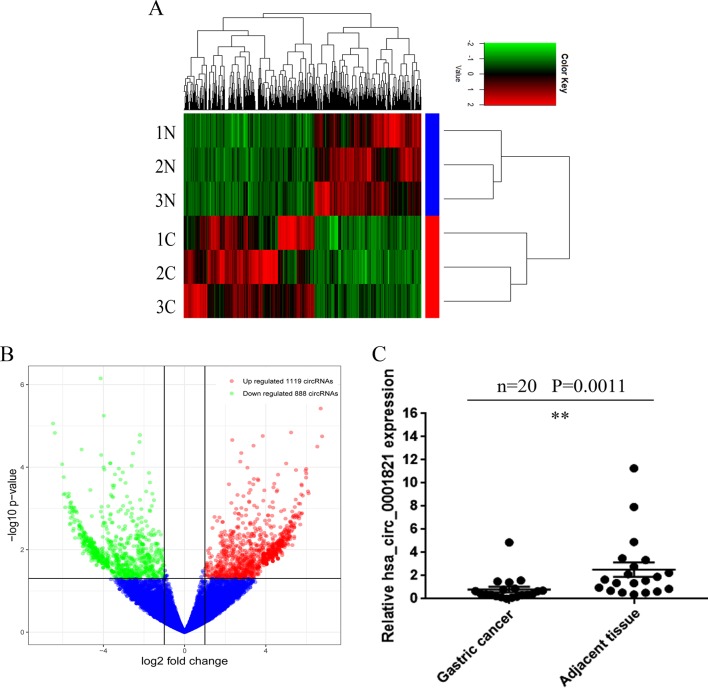
Identification of deregulated circular RNAs (circRNAs) in gastric cancer (GC) tissues. (A) Clustered heatmap. Each row represents a tissue sample, and each column represents a circRNA. The color scale reflects the log2 signal strength from green (low intensity) to black (medium intensity) to red (strong intensity). (B) Volcano plots. The red points in plot indicate the differentially upregulated expression of circRNAs with statistical significance while the green points indicate the downregulated circRNAs. (C) Initial verification of hsa_circ_0001821 expression in 20 pairs of GC tissues by quantitative real-time PCR (qRT-PCR). **P<0.01 were considered significant.